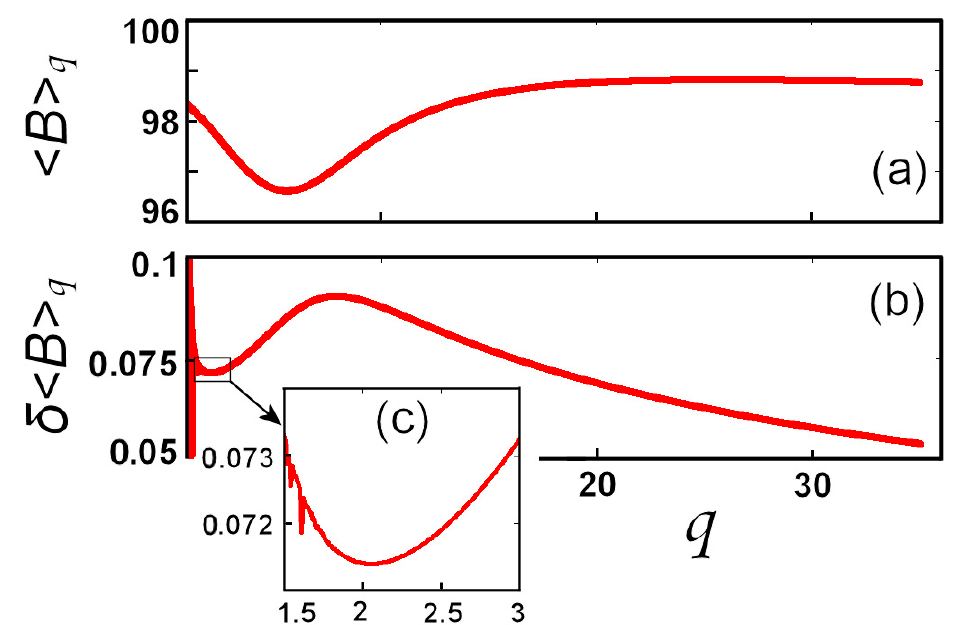
Figure 6. The L q -normed ( a ) expectation value, and ( b ) error, of the magnitude of the Earth’s magnetic field dataset shown in Figure 5a, plotted against the L q -norm. (Modified from [11]).